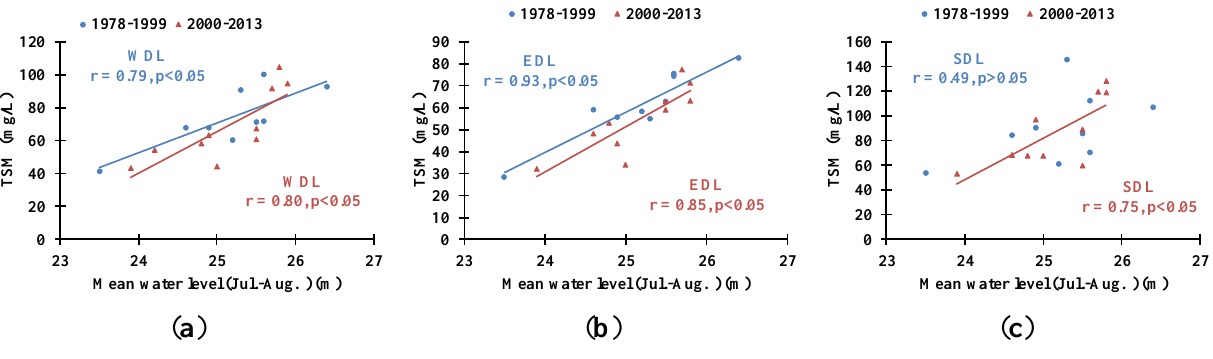
Figure 7. Relationship between mean TSM and mean water level from July to August for WDL ( a ); EDL ( b ) and SDL ( c ). The blue line is the regression line for the years 1978 to 1999 and the red line is the regression line for the years 2000 and 2013.